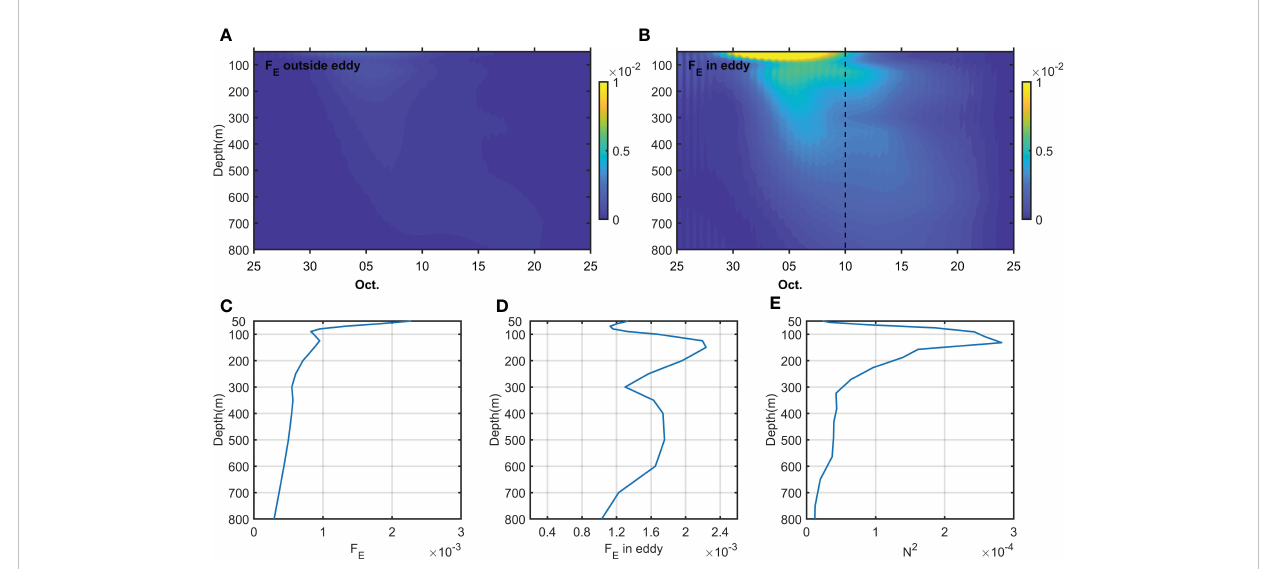
FIGURE 8 Time evolution of F E outside (A) and in (B) the eddy (unit: W/m 2 ). The black dashed line indicates the time when F E in eddy starts to form two peaks in D (10 October). Variation of F E in the region east of Taiwan (C) , F E in the eddy from 10 to 25 October (D) and Buoyancy frequency (E) with